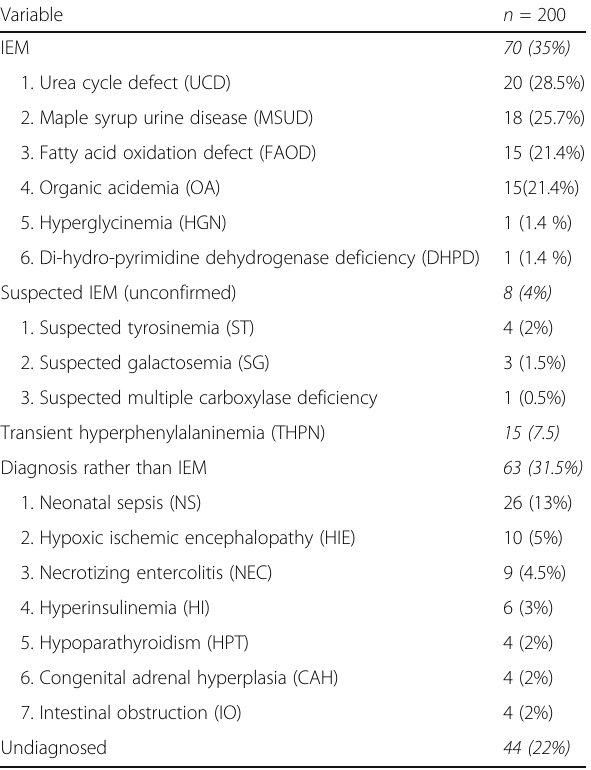
Table 7 The different disease types of the studied cases after routine and specific laboratory finding